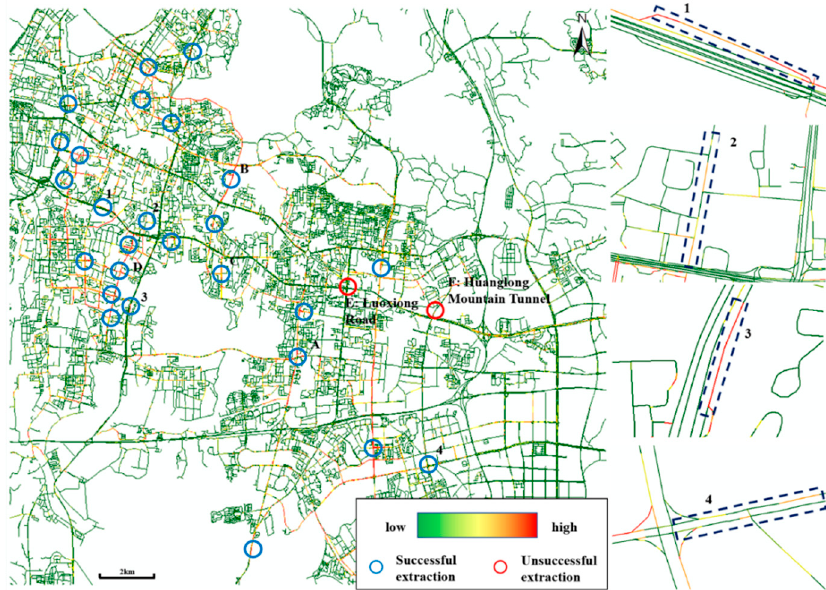
Figure 9. The result of the flooded road extraction method. Symbol A–F mark the six representative roads and 1–4 correspond to the detailed image on the right side.